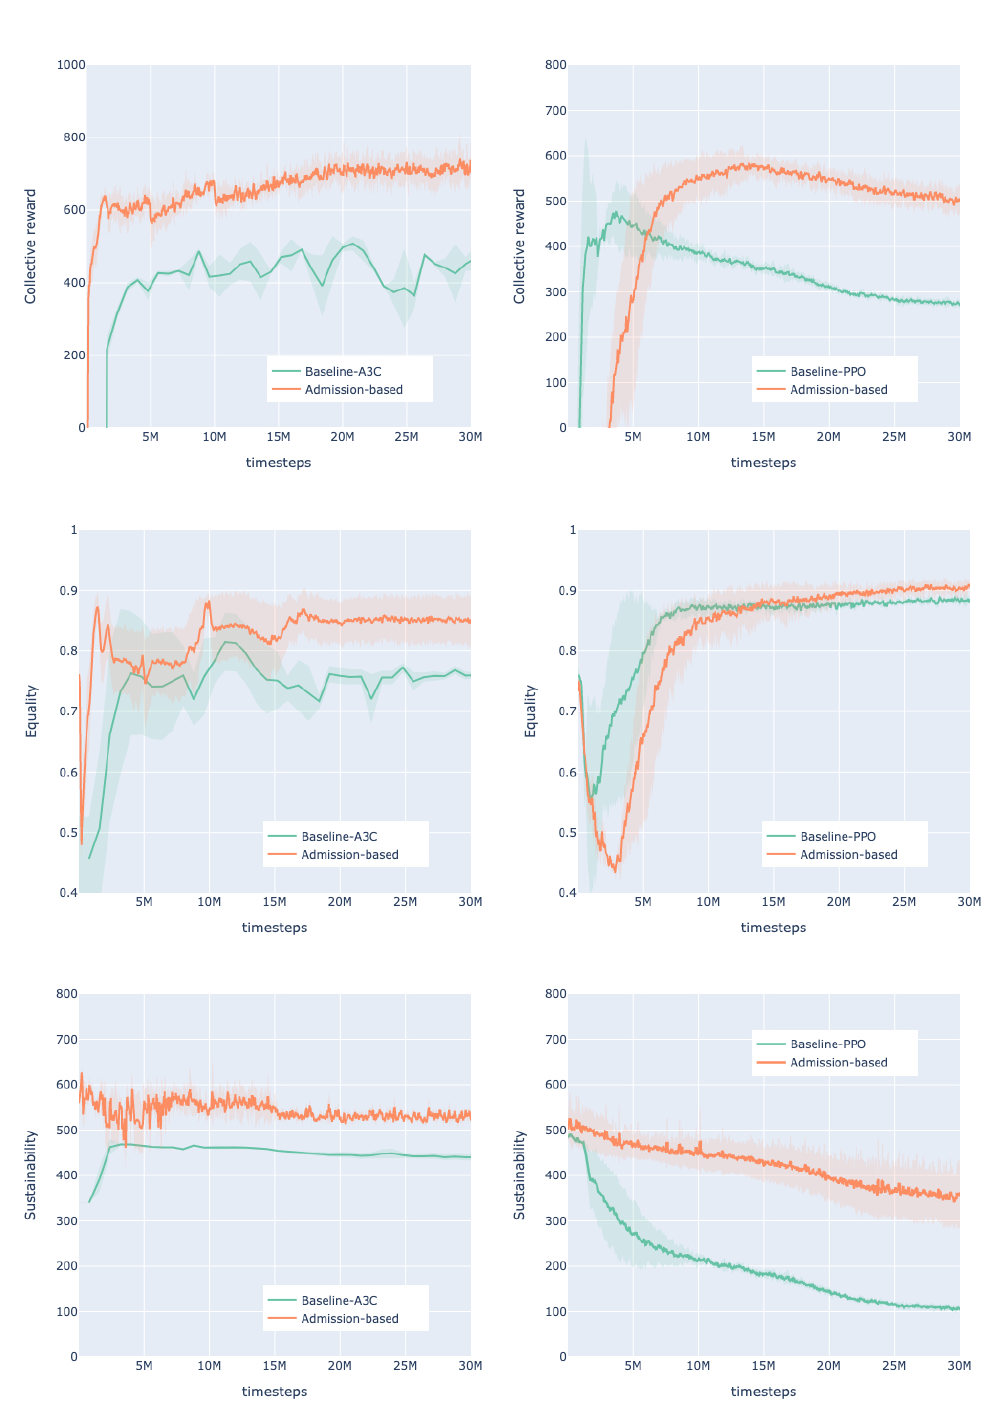
Figure 5. The performance of the Admission algorithm in various metrics in Harvest. The three images on the left and the three images on the right are the results of our algorithm applied to A3C and PPO, respectively. One of the metrics was replaced by the Sustainability